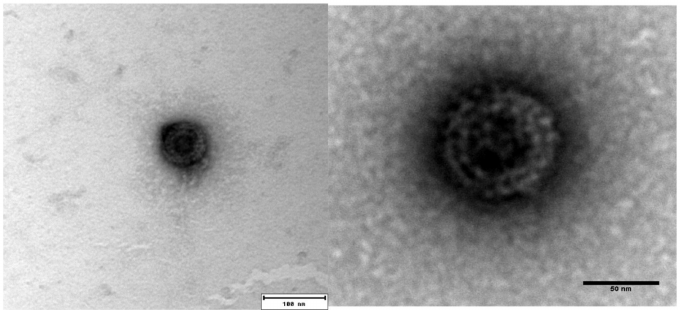
Figure 1. Transmission Electron microscope (TEM) image of negatively stained Piscine orthoreovirus (PRV)-3 showing approximately 75 nm diameter, spherical shaped